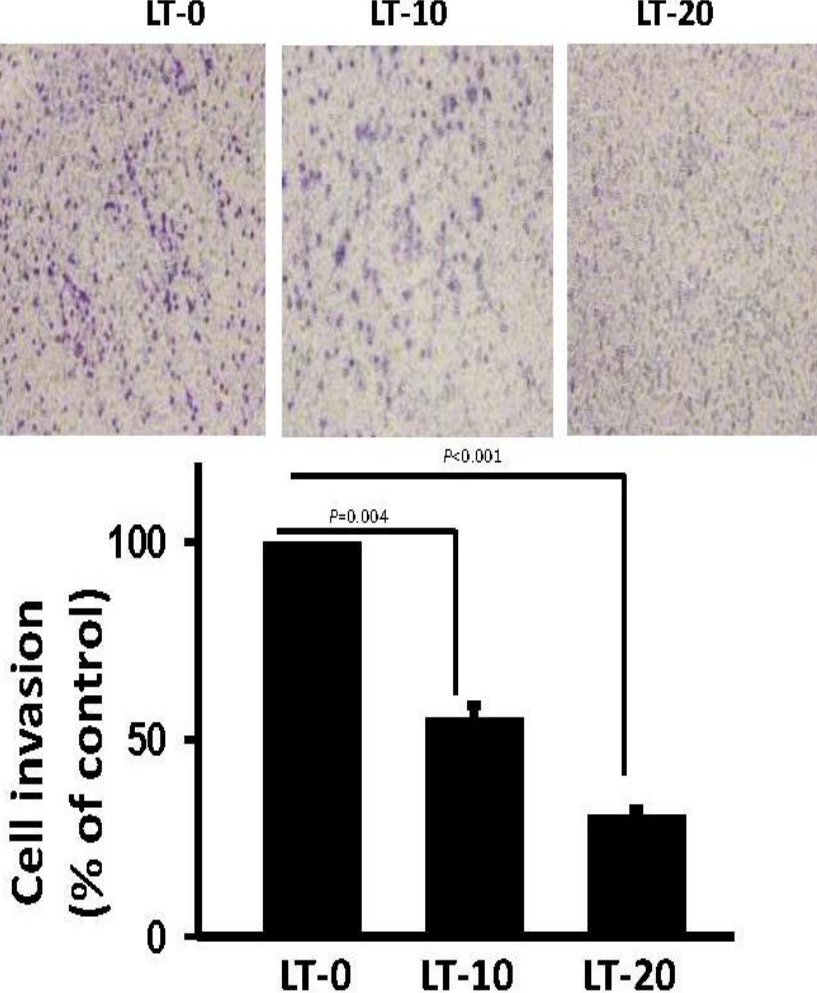
Figure 6: The invasiveness of LT-0, -10, and -20 cells was analyzed using Boyden chambers coated with a layer of Matrigel. All experiments were performed at least three times. P values were determined using Student’s t